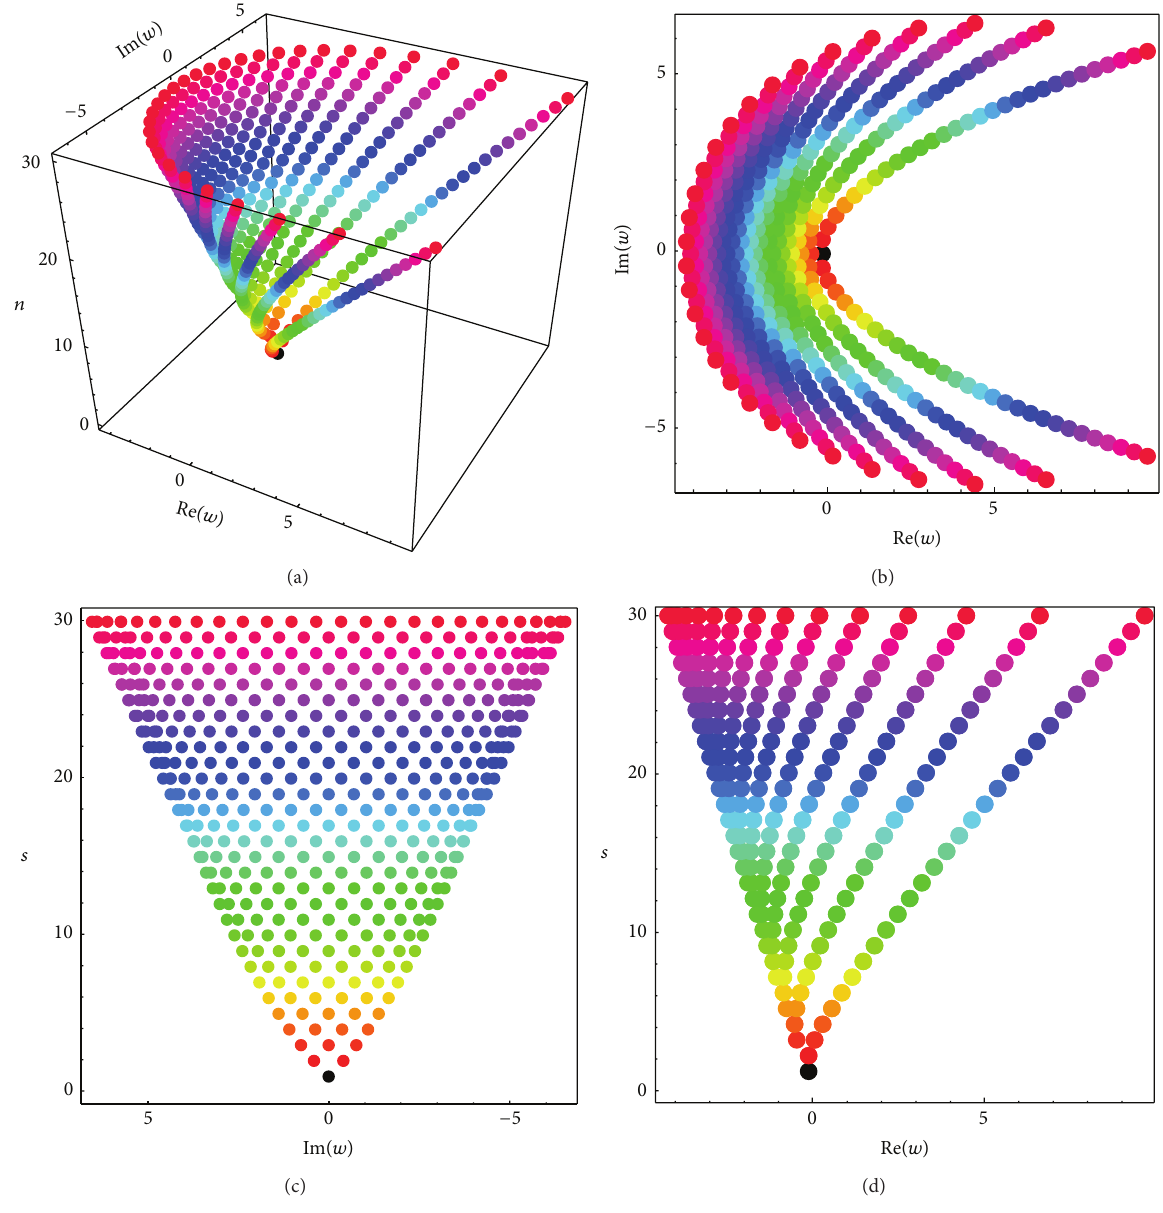
Figure 4: Stacks of zeros of 𝐸 (ℎ) 𝑞 (𝑛,𝑤) for 1 ≤ 𝑛 ≤ 30